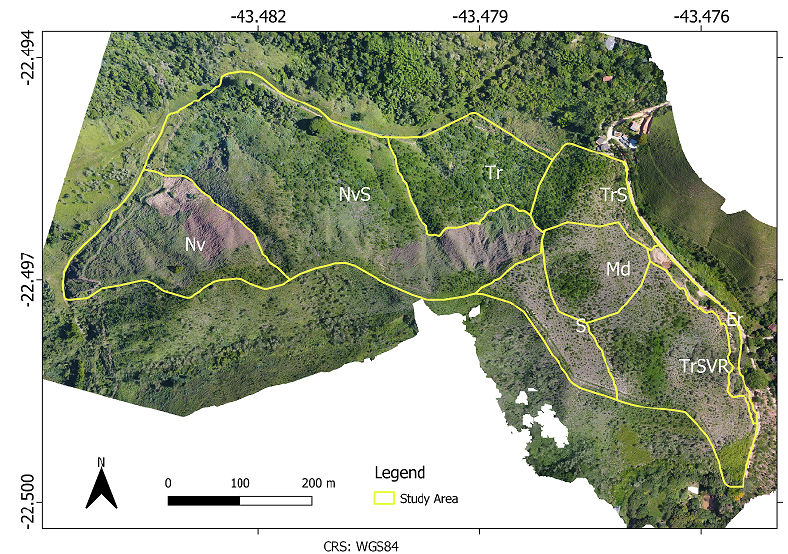
Figure 3. Study area divided into 8 different stretches with more, less, and mixed quantities of forested areas (FR success): Non-vegetated predominance (Nv), Non-vegetated mixed with Seedlings (NvS), Trees predominance (Tr), Trees mixed with Seedlings (TrS), Seedlings predominance (S), Trees mixed with Seedlings mixed with Vegetation Remnants (TrSVR), Erosions (Er) and Model (Md). The Md stretch was the one that best represented the whole study area in general.